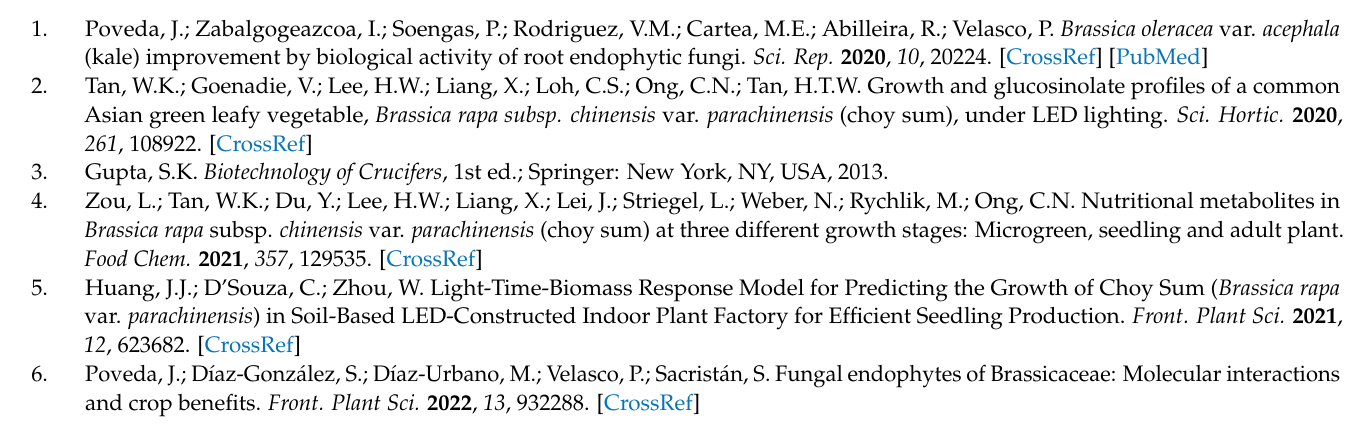
Choy Sum. Figure S3: Total Ion Chromatograms (TIC) for the chemical standards for two important classes of phytohormones i.e Gibberellins and Cytokinins. Figure S4: Multiple Reaction Monitoring (MRM) for gibberellins and cytokinins, together with the precursor ions and fragment ion transitions, respectively. Figure S5: MRM transitions for cytokinins showing the respective precursor ion and the fragment ion transitions. Figure S6: Overlay total ion chromatogram (TIC) for cell free exudates of P. citrinum FLP7 isolate showing three specific gibberellin derivatives. Table S1: Oligonucleotide primers used in this study. Table S2: Selected reaction monitoring conditions for protonated or deprotonated forms of the indicated plant hormones ([M+H] + or [M − H] − ). Table S3: List of volatile organic compounds emitted during P. citrinum -derived growth promotion of Choy